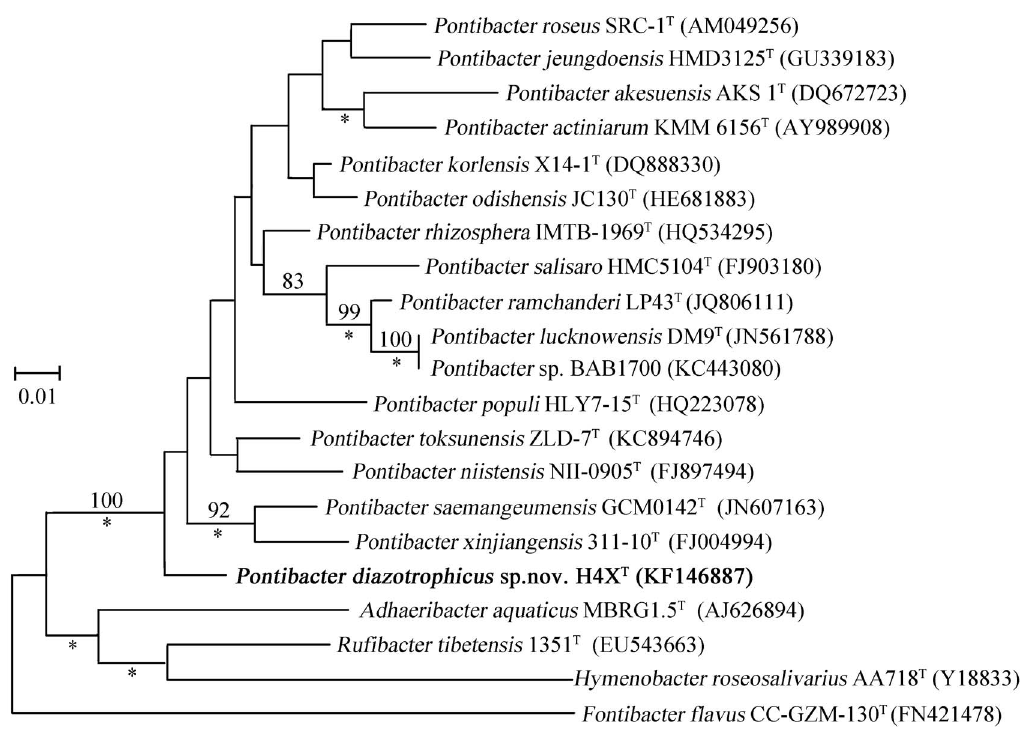
Figure 1. Maximum-likelihood phylogenetic tree based on multiple sequence alignment of 16S rRNA genes of the isolate Pontibacterdiazotrophicus sp. nov. H4X T and other closely related type strains. Bootstrap values (expressed as percentages of 1000 replicates) that are . 75% are shown at branch points. Asterisks indicate that the corresponding nodes were also recovered in the Bayesian tree. Bar, 0.01 substitutions per nucleotide position.